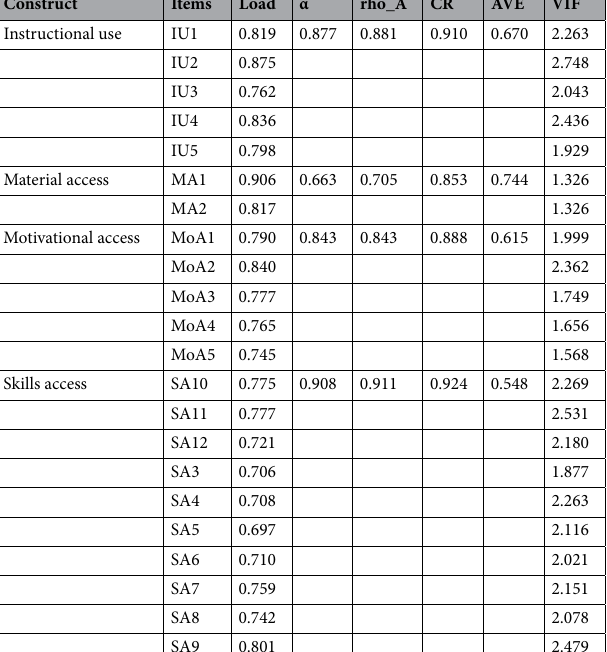
Table 2. Factor loading, reliability, and validity of measurement